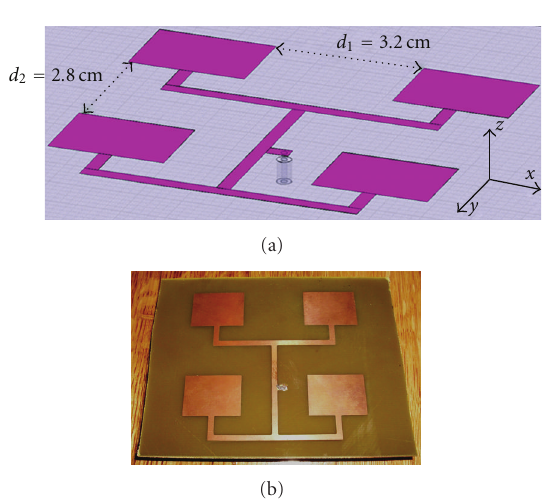
Figure 2: Antenna geometry and measurements; (a) antenna mod- el, (b) antenna prototype.